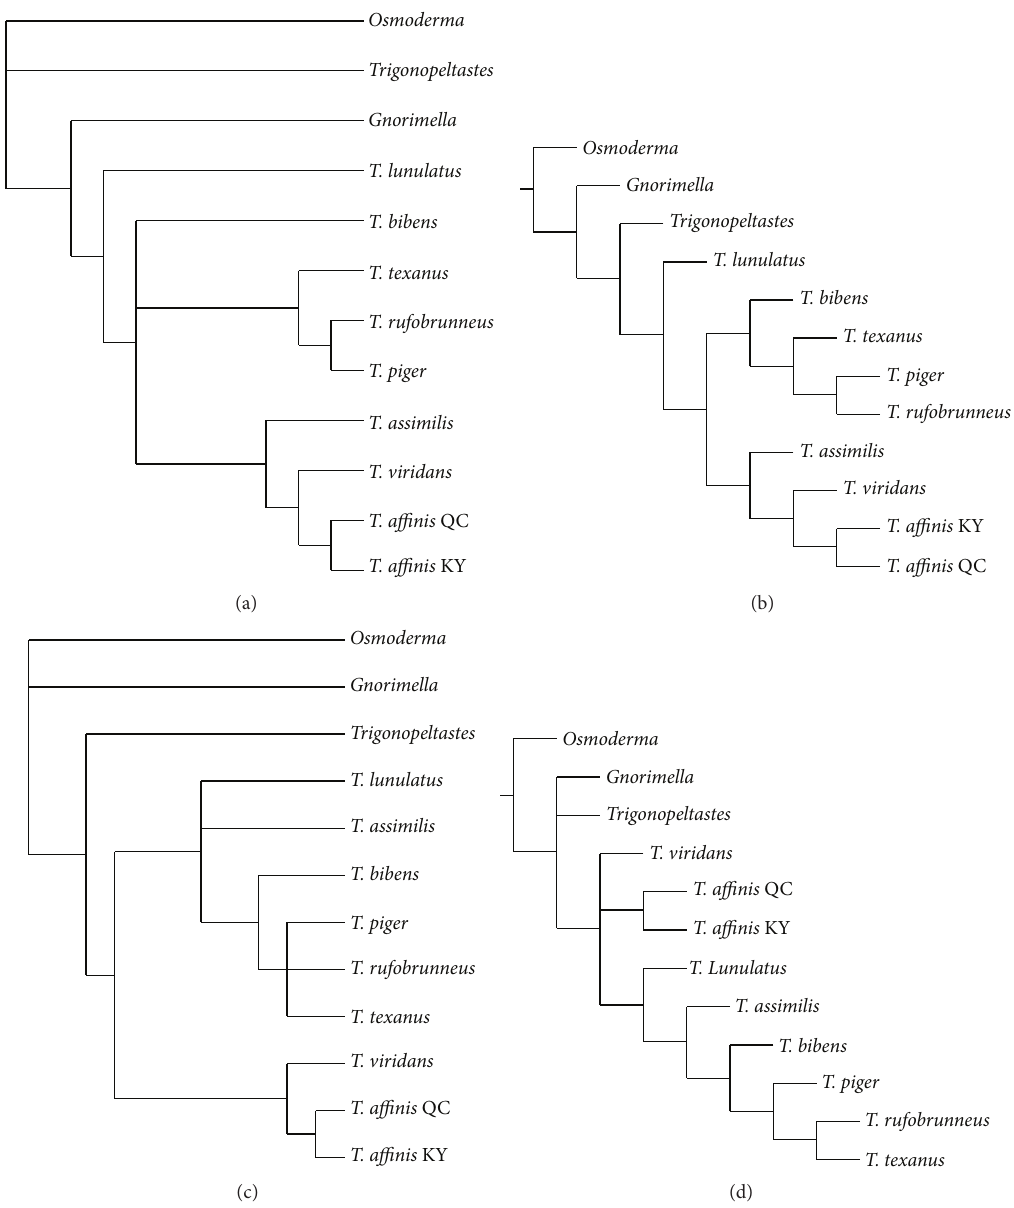
Figure 3: The Bayesian and parsimony analyses using molecular data. (a) Bayesian analysis using the CO1 data. The tree is similar to that found with the total evidence except for an unresolved trichotomy near the base of the topology; (b) parsimony analysis using CO1 data. The tree is identical to that found with the total evidence; (c) Bayesian analysis using 28S data; (d) Parsimony analysis using 28S data, strict consensus of two